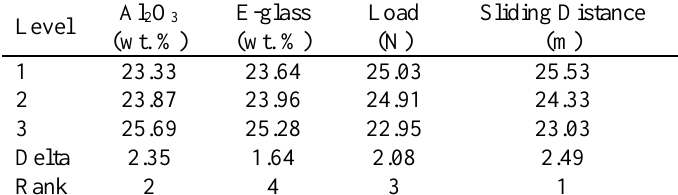
Table 5. Wear rate of response table for SN